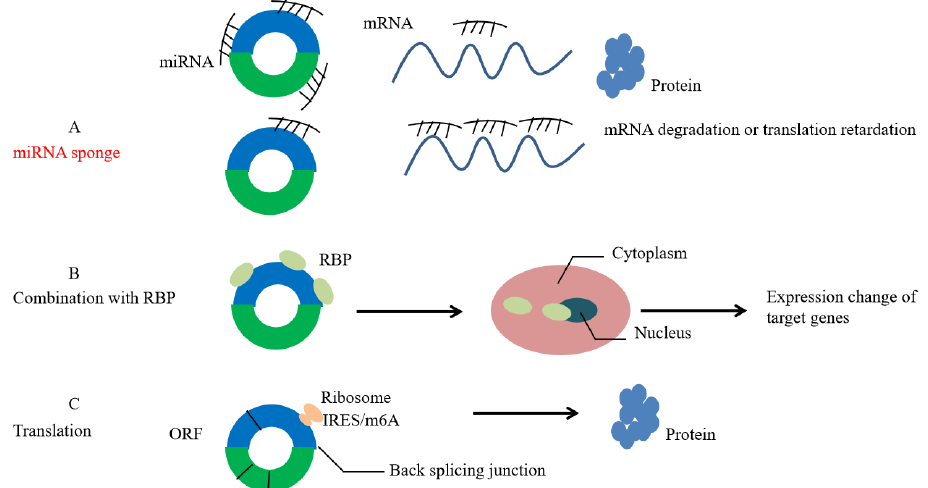
Figure 2. Function of circRNA. ( A ): circRNAs act as miRNA sponge. ( B ): circRNAs affect the function of RNA-binding protein (RBP). ( C ): circRNAs possess the function of translation by internal ribosome entry site (IRES) and methylation of adenosine N6 (m6A). (2) CircRNA can affect the function of RNA-binding protein. It has an advanced